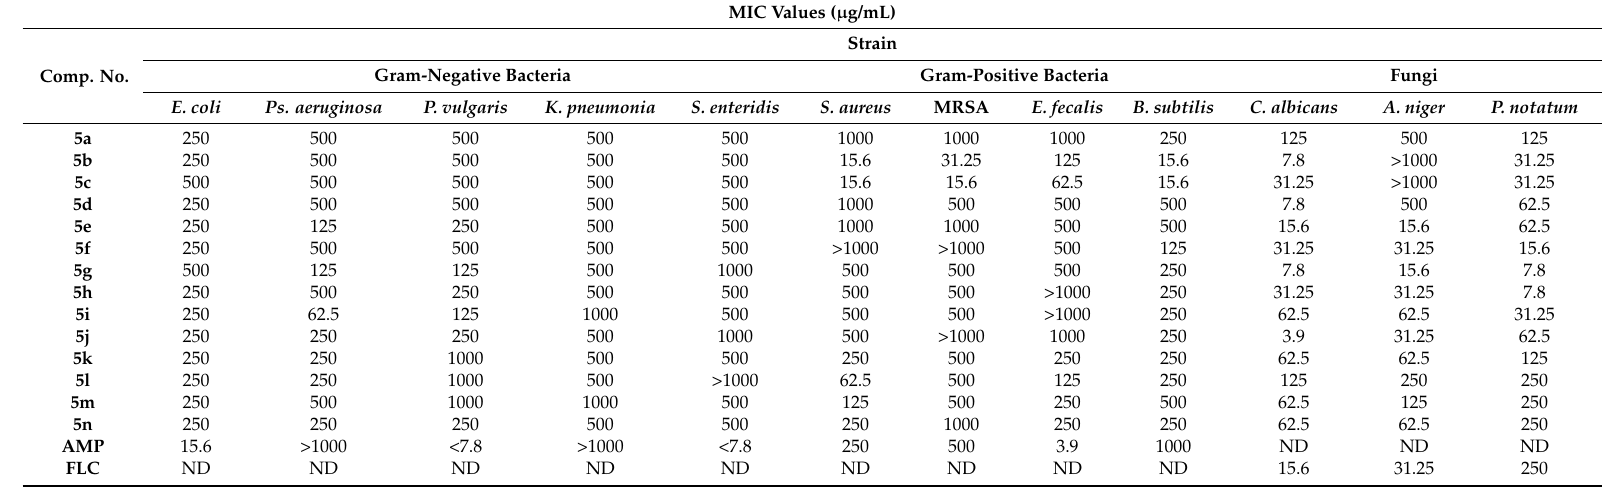
Table 2. Minimum inhibitory concentrations (MICs) of the title compounds 5a – n , ampicillin (AMP) and fluconazole (FLC) toward Gram-negative and -positive bacteria and